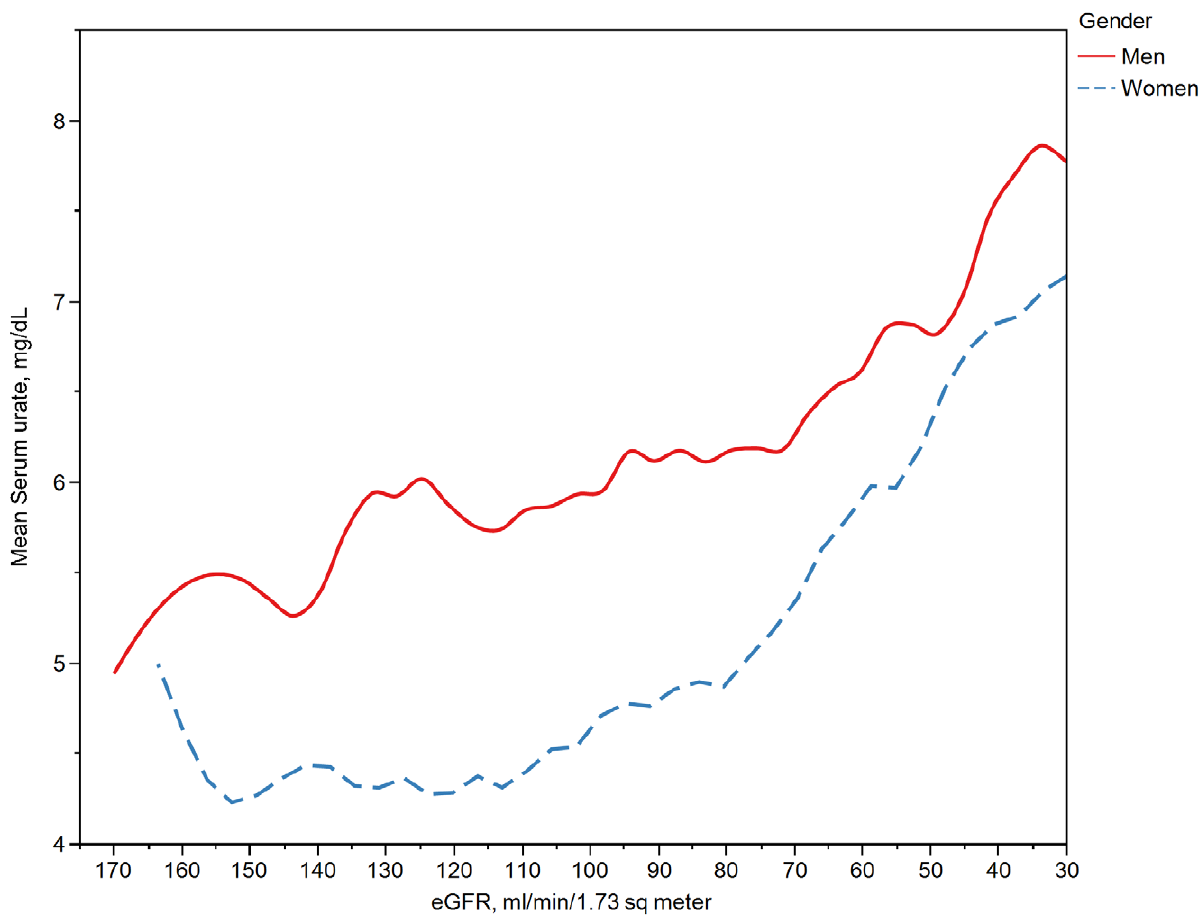
Figure 2. Bivariate association between estimated glomerular filtration rate and serum urate concentrations. The curves based on mean serum urate concentration vs. eGFR were fitted by locally weighted scatterplot smoothing (lowess) regressions using unweighted data. Conversion factors for units: serum urate in mg/dL to m mole/L, 6 59.48.